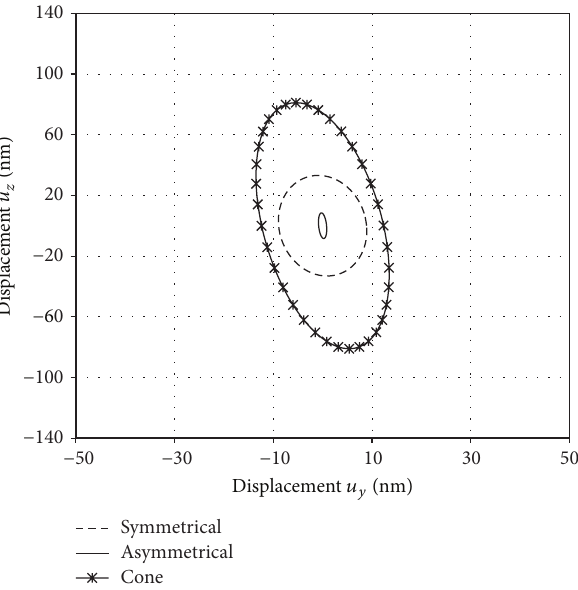
Figure 7: Trajectories of the contact point motion of analyzed piezoelectric